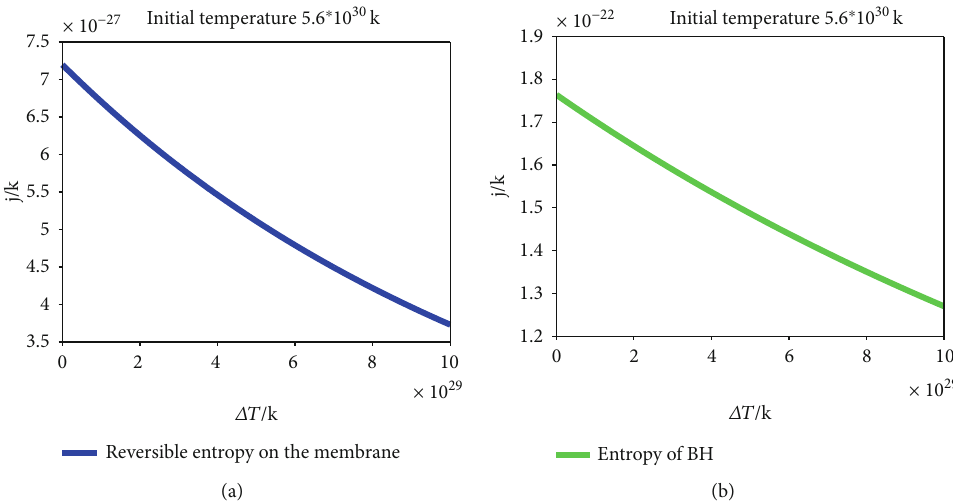
Figure 3: (a) shows the relationship between the reversible entropy of membrane and temperature di ff erence with an initial temperature 5 : 6 × 10 30 k (it was only in the very early universe that such high temperatures were possible). Black holes of various masses have the same trend as the temperature di ff erence becomes larger, and the reversible entropy monotonically decreases. (b) shows change of entropy of the black hole with an initial temperature 5 : 6 × 10 30